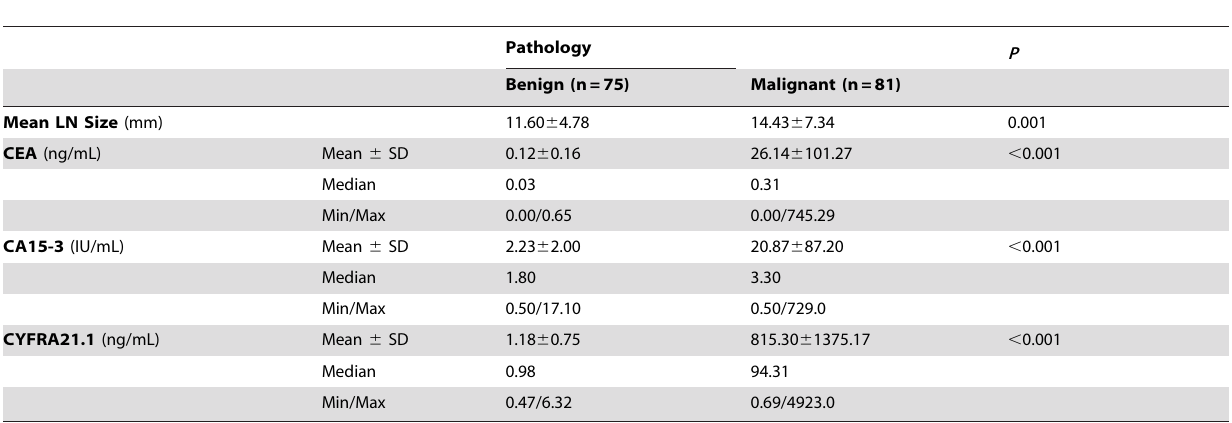
Table 1. Mean size and concentrations of CA125, CA19-9, and CYFRA 21-1 in US-FNAB aspirates of the 156 axillary lymph nodes.